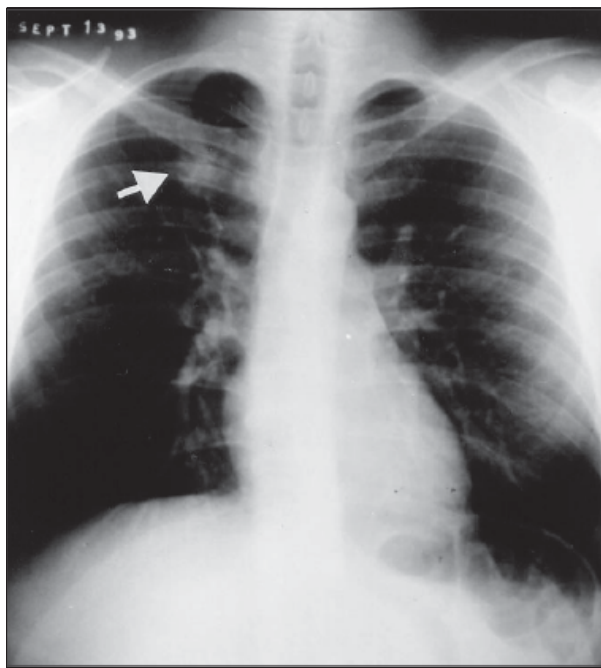
Figure 1) Human blastomycotic nodule. Chest x-ray of index case 1 showing a right upper lobe nodule